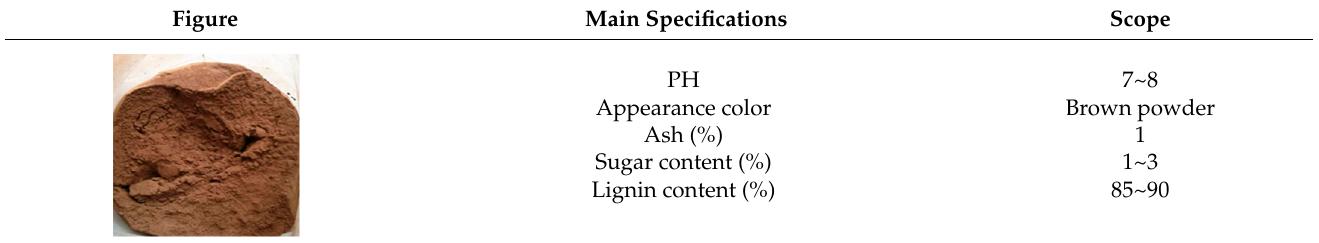
Table 1. Main technical indexes, molecular weight, and pyrolysis parameters of lignin. Figure Main Figure Main Specifications Scope